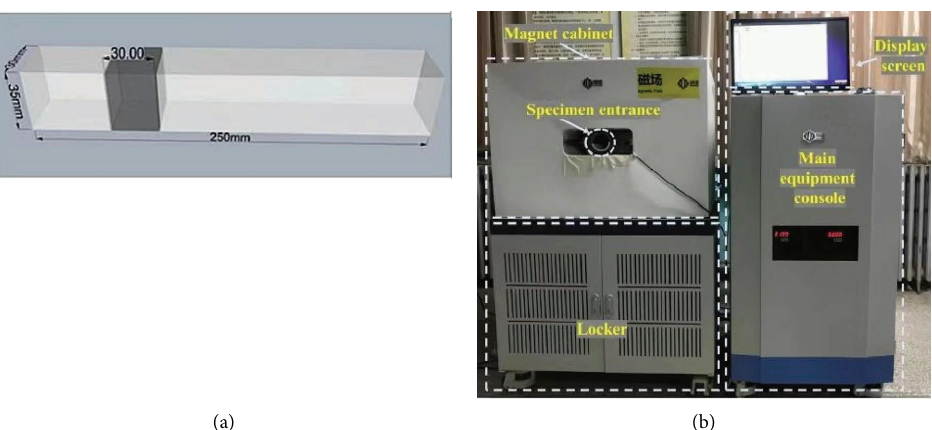
Figure 2: NMR: (a) schematic diagram of cutting the original specimen; (b) mesoMR23-060H-I nuclear magnetic resonance spectrometer. Light 1